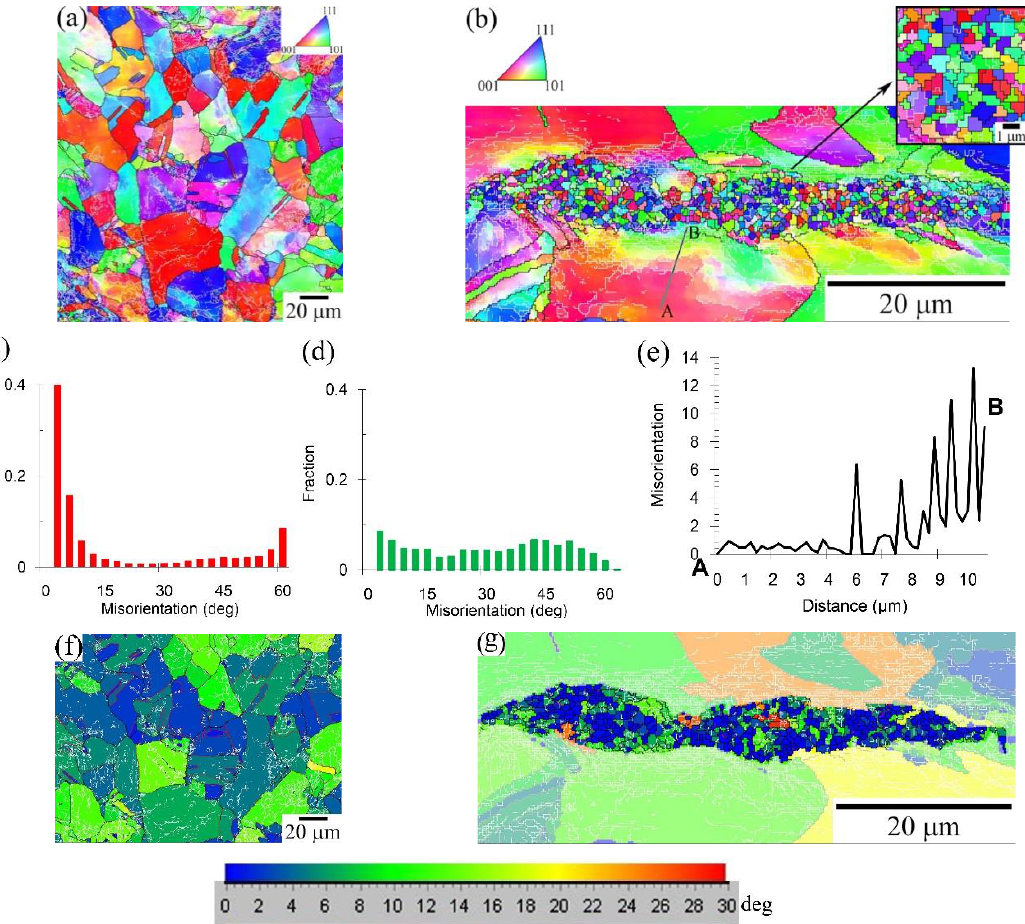
Figure 6. Microstructures of different zones in the ultrasonically consolidated sample: ( a , b ) typical crystal orientation maps taken from coarse-grained and fine-grained zones, respectively; ( c , d ) corresponding misorientation angle distributions of grain boundaries; ( e ) misorientation profile along line AB on ( b ); ( f , g ) grain average misorientation maps obtained from the coarse-grained and fine-grained zones, respectively; the color code of intragrain misorientations for ( f , g ) is shown under the maps.